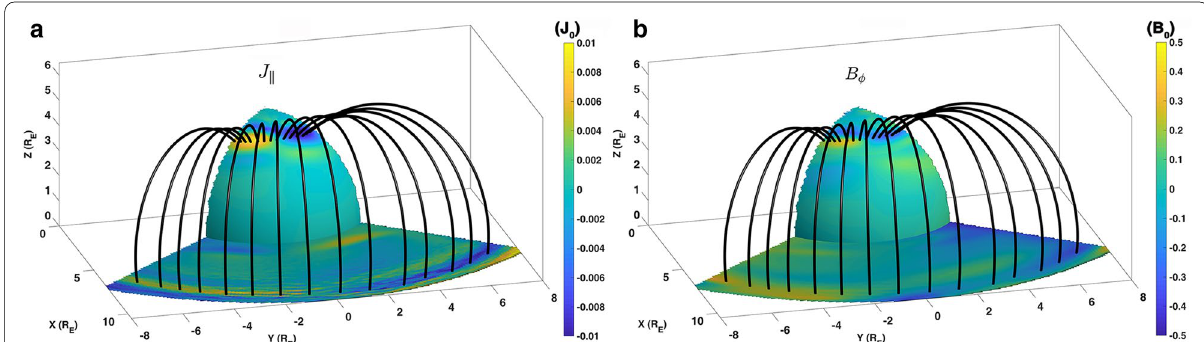
4 R E ). Typical magnetic field lines through the strongest FAC =